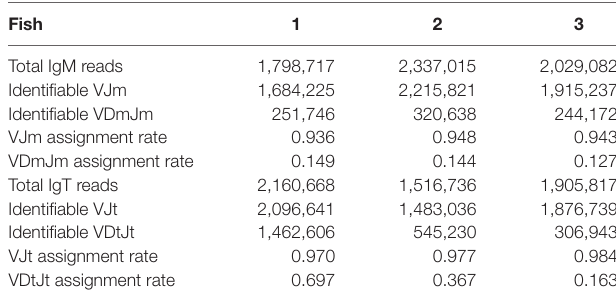
Table 1 | Summary of consensus reads assigned to each V, D, and J gene segment measured for both IgM and IgT groups.